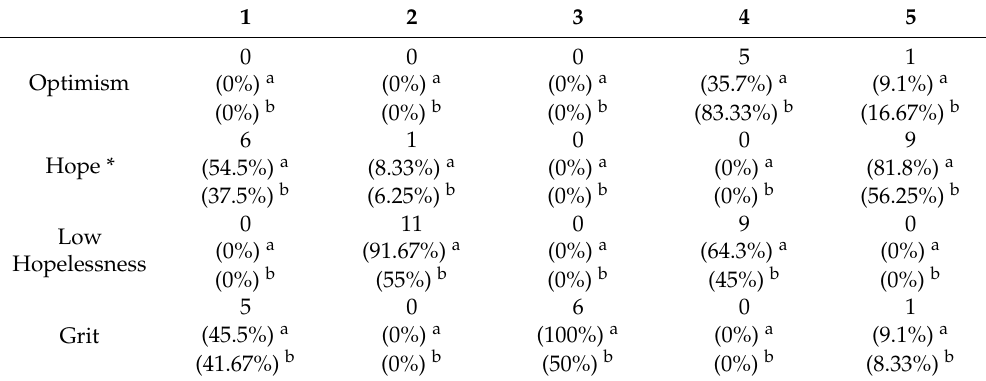
Table 4. Number and Percentage of Items That Most Strongly Loaded on Each Retained Factor. 1